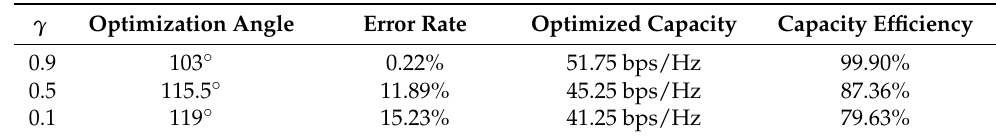
Table 10. Optimized values for antenna downtilt and channel capacity with different discount rates at D = 100 m.